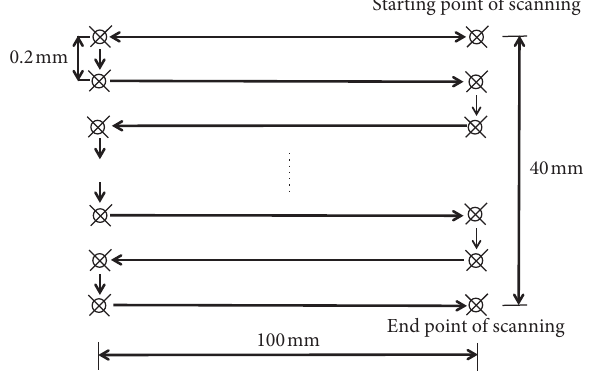
Figure 1: Route laser scanning on the testing.